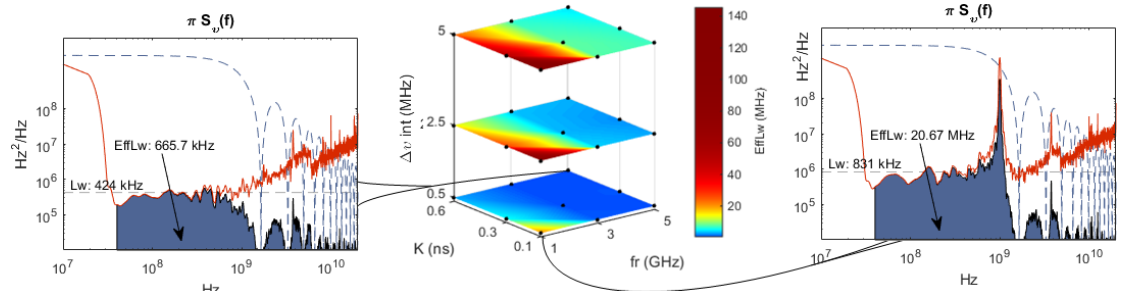
Figure 9. Calculations of effective linewidth on experimental data for 17 carrier-phase recovery (CPR) taps.